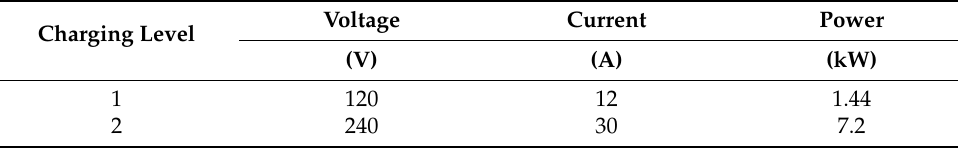
Table 2. Charging levels based on the SAE J1772 standard.